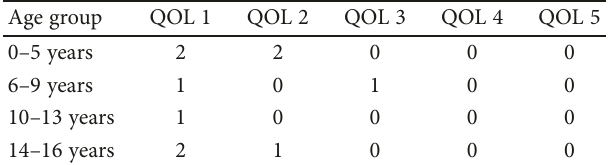
Table 8: IA and IV injection and quality of life score with respect to the age groups.